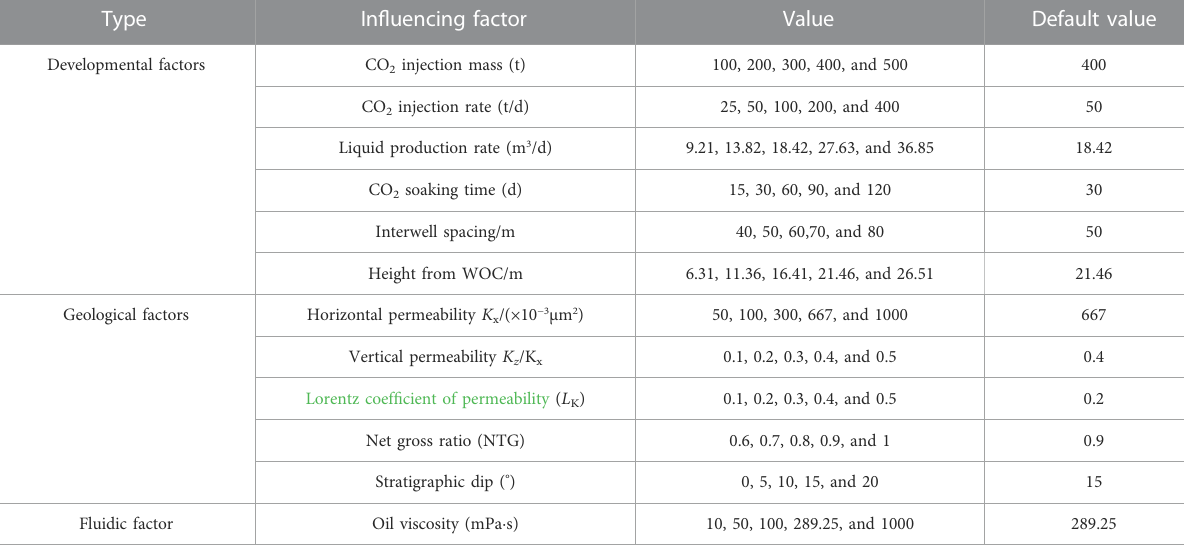
TABLE 5 Sensitivity analysis designed for the well-to-well interplay of CO 2